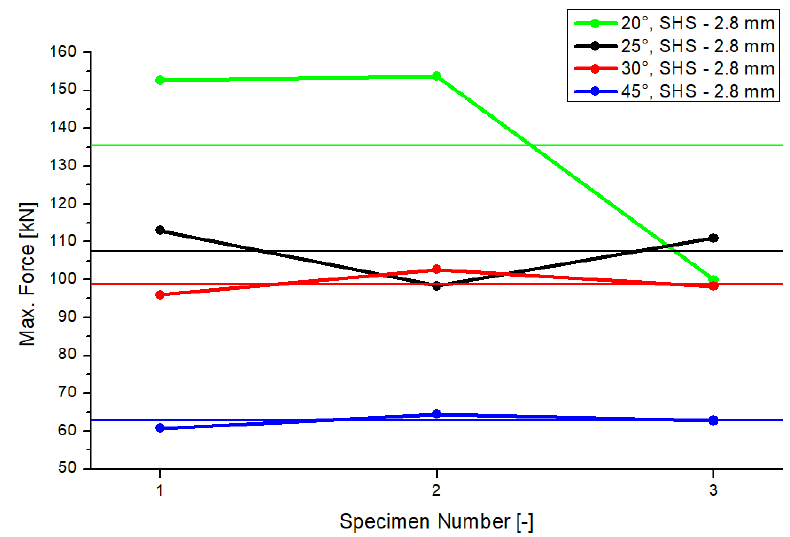
Figure 4. Results of the maximum compression force.